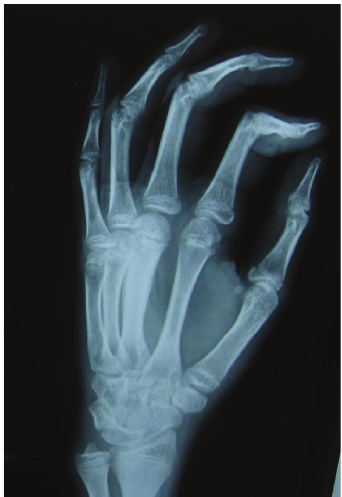
Figure 2: Radiograph of right foot (AP view), showing irregular destruction of proximal phalanx of 3rd toe and cortical thickening of 4th metatarsal with solid periosteal